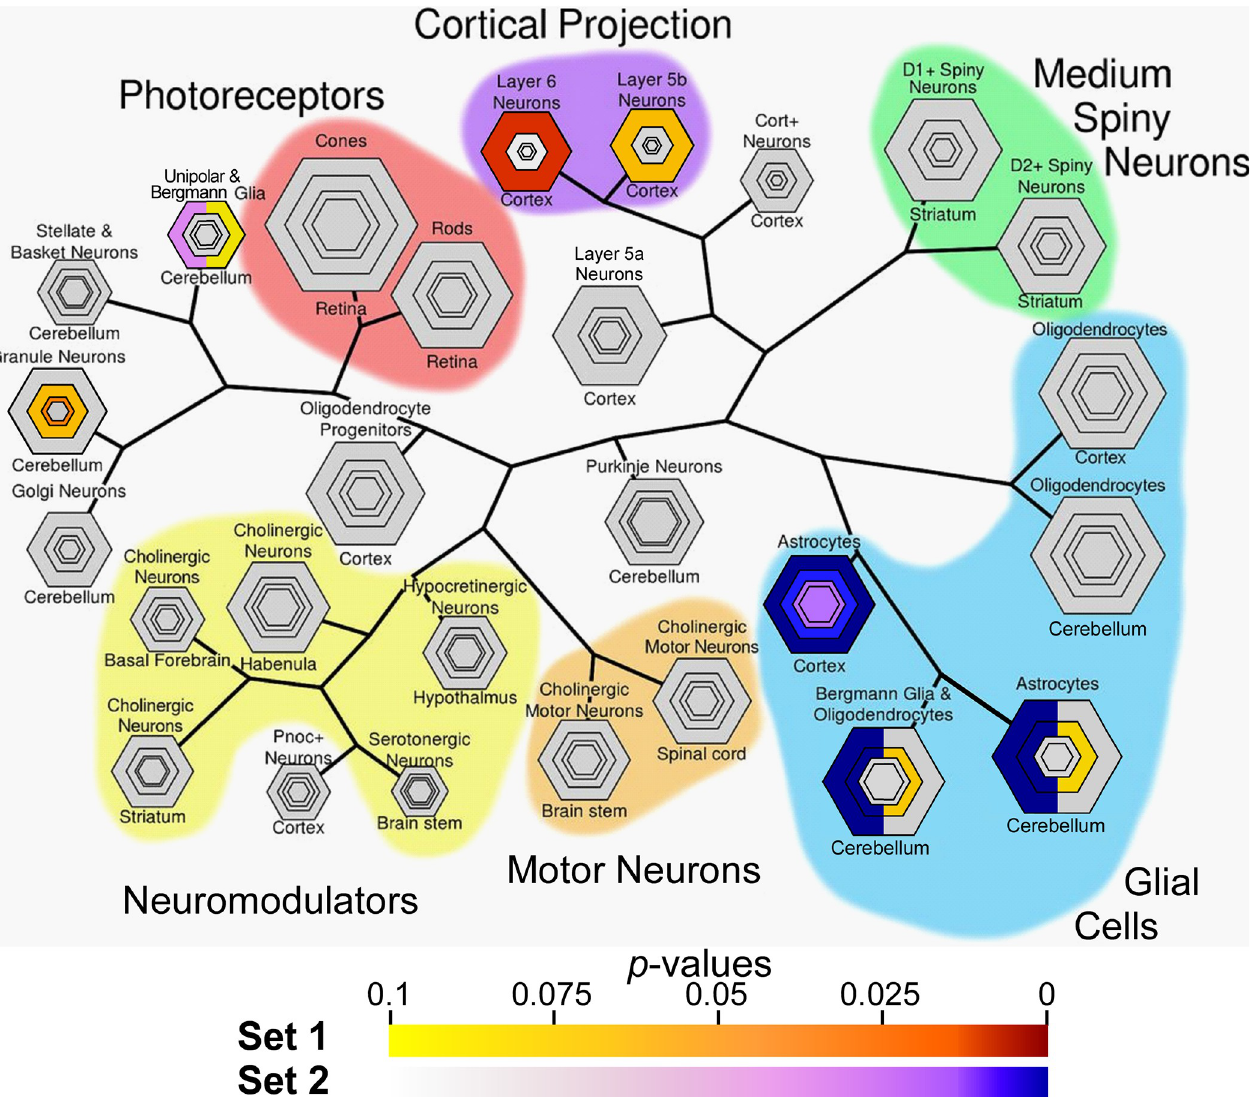
Fig 5. Cell specific enrichment analysis (CSEA) of Gene Sets 1 and 2. Bulls-eye plots, where hexagon size scales with specificity for listed cell types. Each concentric ring conforms to specificity index probability statistic (pSI) at thresholds of 0.05, 0.01, 0.001 and 0.0001 (ordered from outermost to innermost ring), where lower thresholds represent higher cell specificity. Statistical overlap between gene sets with cell-type specific markers are depicted according to Benjamini-Hochberg adjusted p -values. Gene Set 1 uniquely enriched for genes expressed by layer 5b and layer 6 neurons of the cortex and granule neurons of the CB, and more weakly with unipolar cells/Bergmann glia of CB. In contrast, Set 2 genes enriched with astrocytes very strongly across all levels of specificity, and more weakly with unipolar cells/Bergmann glia of CB. Neither gene set associated significantly with